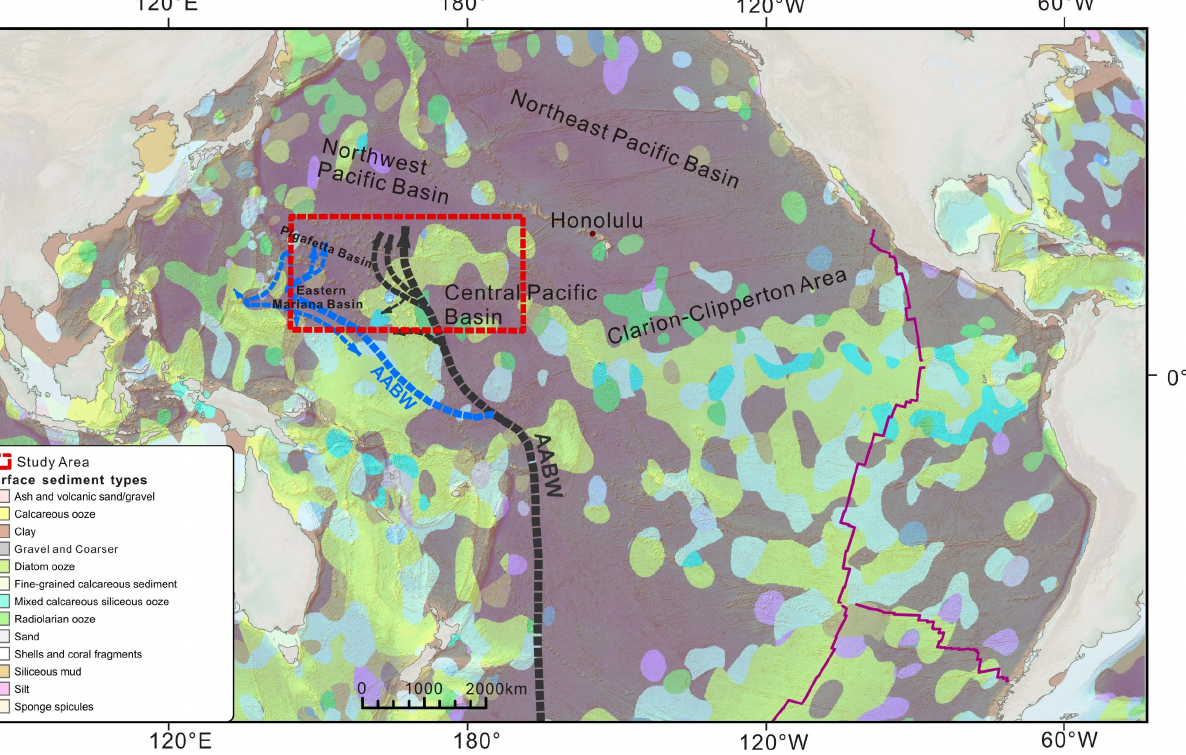
Figure 1. Surface sediment types and Antarctic Bottom Water (AABW) flow path. (Sediment types after [25], AABW path after [26]).